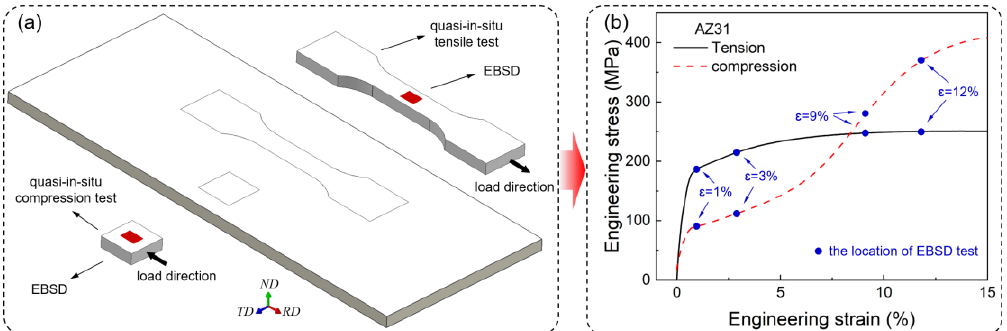
Figure 1. ( a ) The schematic diagram of the sample fabrication and ( b ) the quasi in situ performance curves of the as-rolled AZ31 specimens. ( a ) Tensile and compression samples of AZ31 and WE43 were fabricated from the as-rolled plate, followed by a quasi in situ EBSD test on the ND surface of the samples. ( b ) Quasi in situ EBSD tests were conducted at strain levels of 1%, 3%, 9%, and 12%, both tension and compression.